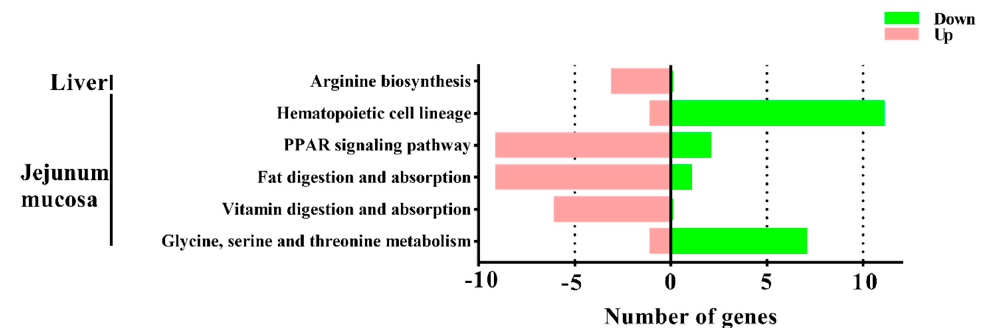
Figure 2. Pathway assignments of differential expressed transcripts in the liver and jejunal mucosa of pigs based on the Kyoto Encyclopedia of Genes and Genomes (KEGG). ClueGO (a plugin for Cytoscape) was used for KEGG analysis, and a p value < 0.05 was used as the threshold to select significant KEGG pathways. The pink bars indicate the number of upregulated genes, while the green bars indicate the number of downregulated genes.